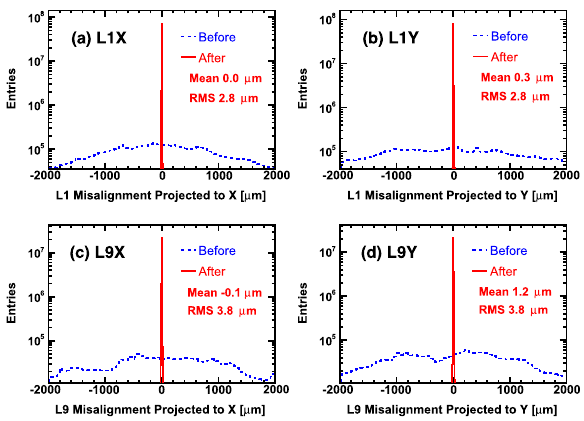
Fig. 12 Misalignments of L1 ( a , b ) and L9 ( c , d ) before (dashed his- tograms) and after (solid histograms) the dynamic alignment derived from the MC simulation. For every 100,000 simulated events passing through either L1 or L9, the positions of the external layers in the MC are randomly displaced, which is then followed by a dynamic align- ment. One entry of misalignment in each histogram corresponds to one set of displacements of the external layers. With the alignment, the mis- alignments projected to x ( a , c ) and y ( b , d ) coordinates are reduced from more than a thousand microns down to 2.8 µ m for L1 and 3.8 µ m for L9